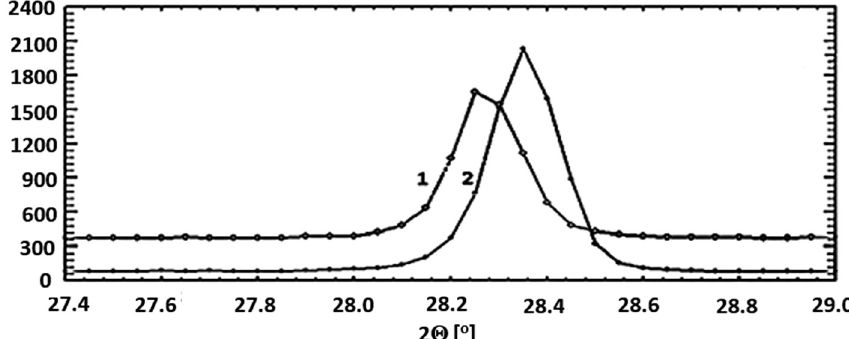
Figure 7: The shift of re fl exes in the di ff ractograms of precipitates due to decrease in the calcium content and simultaneously increase in the magnesium content; ( 1 ) and ( 2 ) di ff ractograms of freshly deposited and collected after 3 - days precipitates,